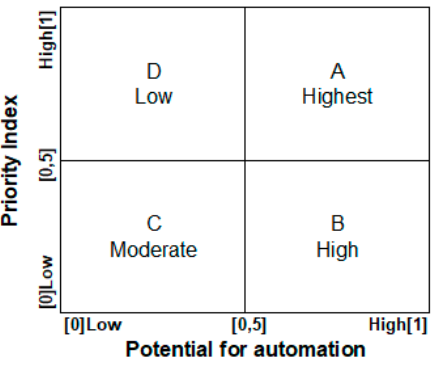
Figure 7. Classification quadrant.